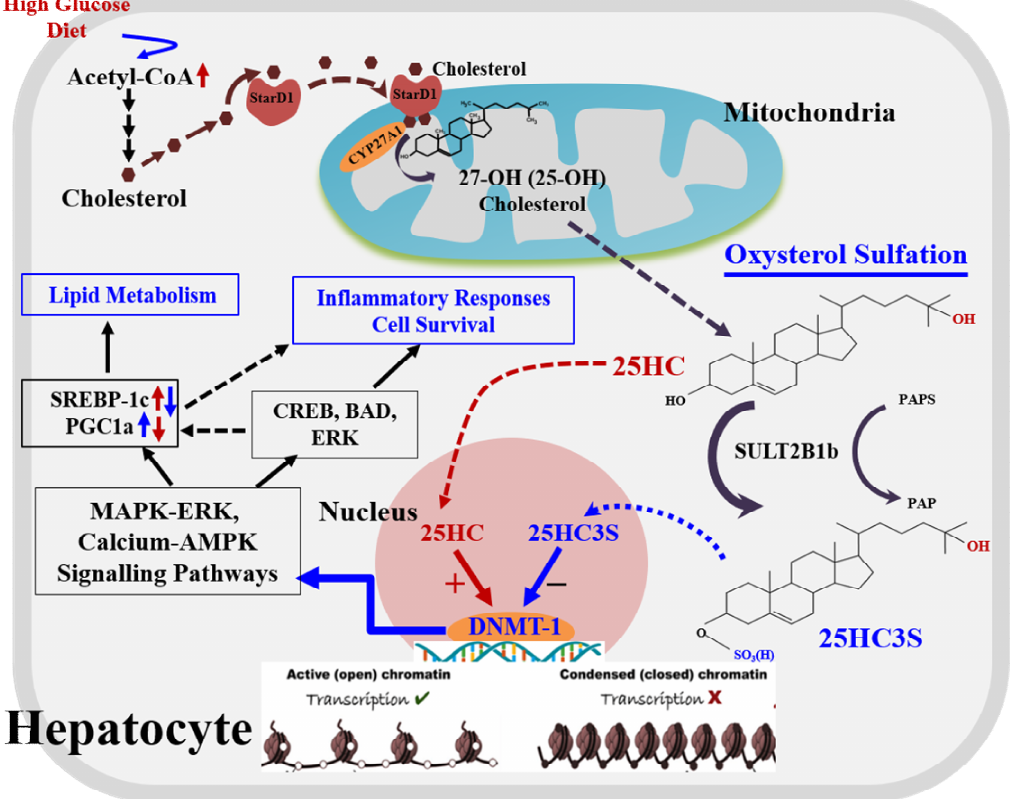
Figure 2. A novel regulatory pathway of oxysterol sulfation.